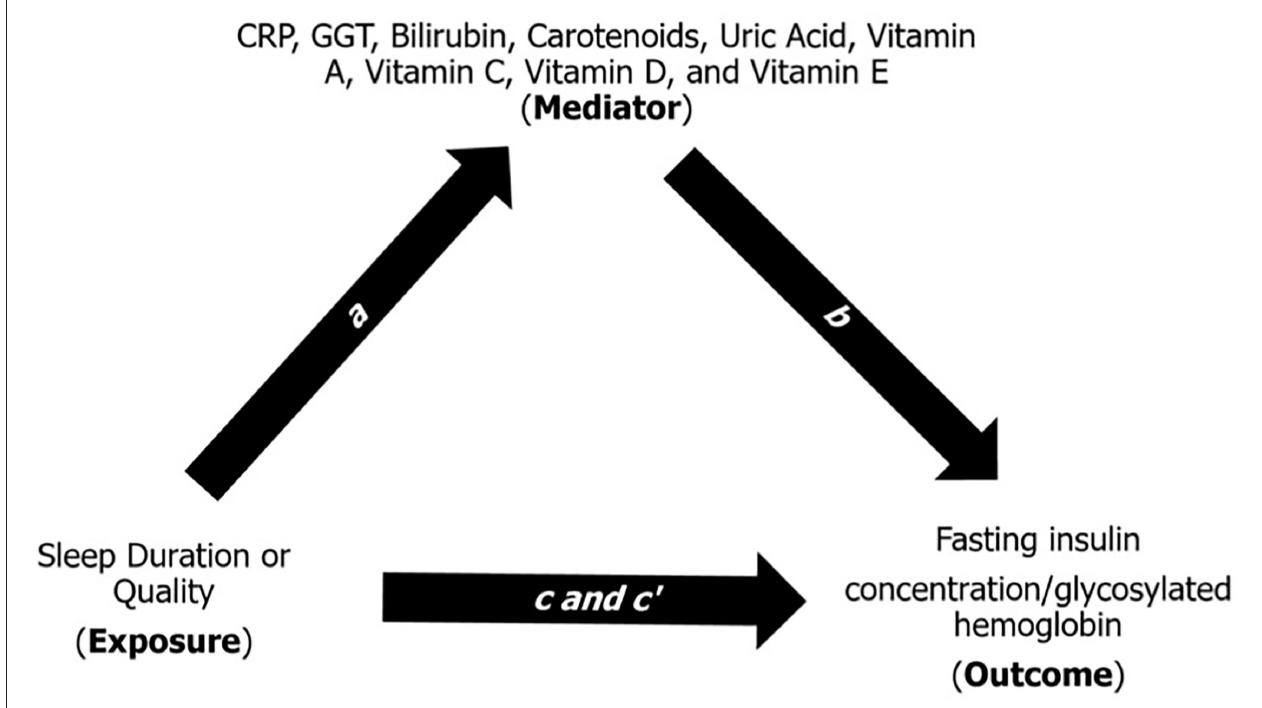
FIGURE 1 | Multiple regression method of the indirect mediation model (22). Path a is a regression analysis between the exposure (e.g., sleep duration or quality) and the mediator (e.g., CRP, GGT, bilirubin, carotenoids, uric acid, and vitamins A, C, D, and E). Path b is a regression analysis between the mediator and the outcome (e.g., fasting insulin concentration) adjusting for the exposure. Path c is a regression analysis between the exposure and outcome. Path c’ is a regression analysis between the exposure and the outcome adjusting for the mediator. The indirect effect ( ab ) estimate is the amount of contribution a mediator provides to the relationship between an exposure and an outcome. CRP, C-reactive protein; GGT, gamma-glutamyl transferase. Each mediator was tested one-by-one in the mediation